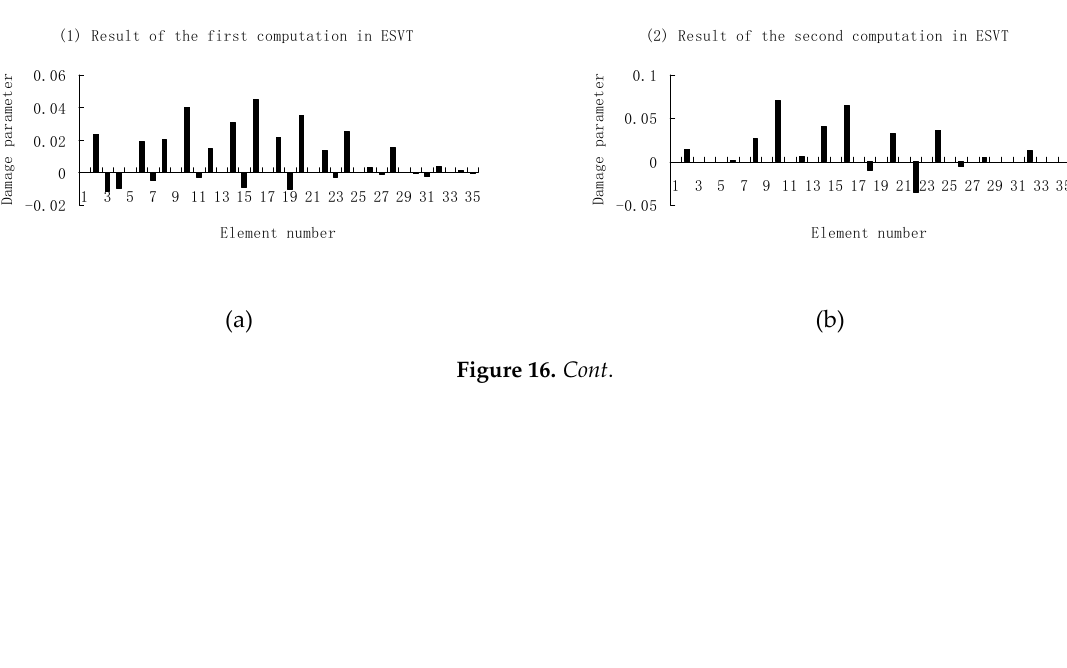
Figure 15. Damage evaluation results of the first to fifth computations in ESVT using the first three frequencies (element 10 had 20% stiffness reduction). ( a )Result of the first computation in ESVT; ( b ) Result of the second computation in ESVT; ( c )Result of the third computation in ESVT; ( d )Result of the fourth computation in ESVT; ( e )Result of the fifth computation in ESVT.